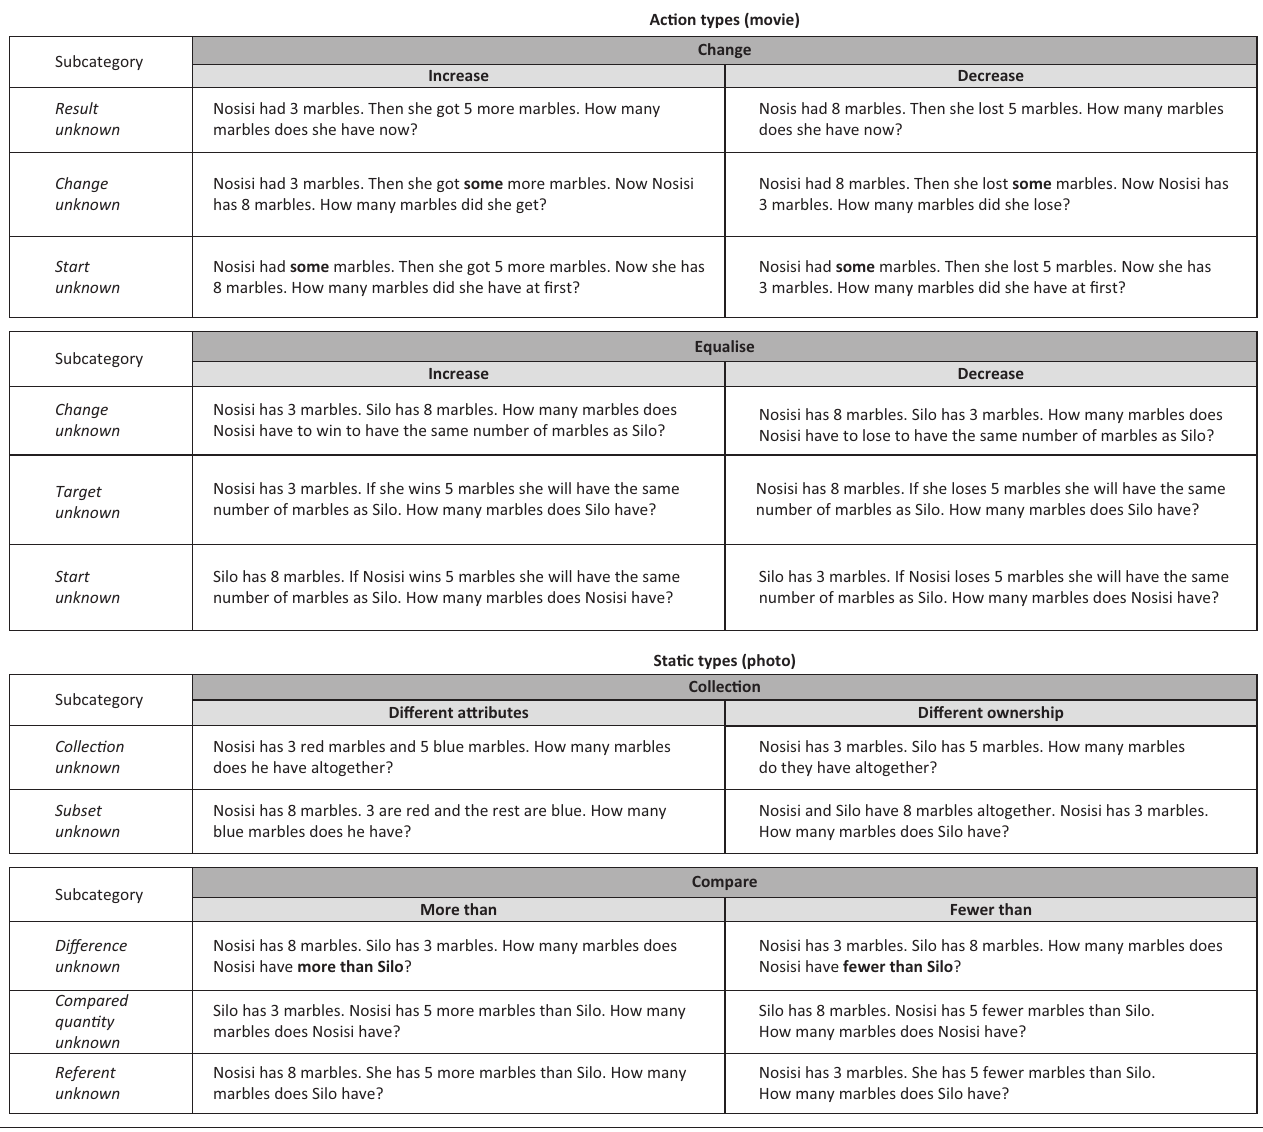
FIGURE 9: Exemplification of comprehensive